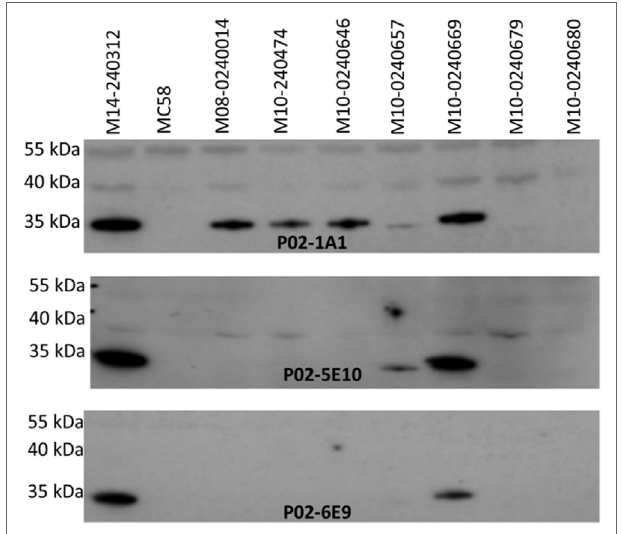
FigUre 4 | Specificity of patient-derived antimeningococcal (hmAbs) for linear epitopes in denaturing western blots. Lysates from normalized suspensions of selected MenB strains were used as template in western blot experiments. A 1:1,000 dilution of each hmAb was employed.